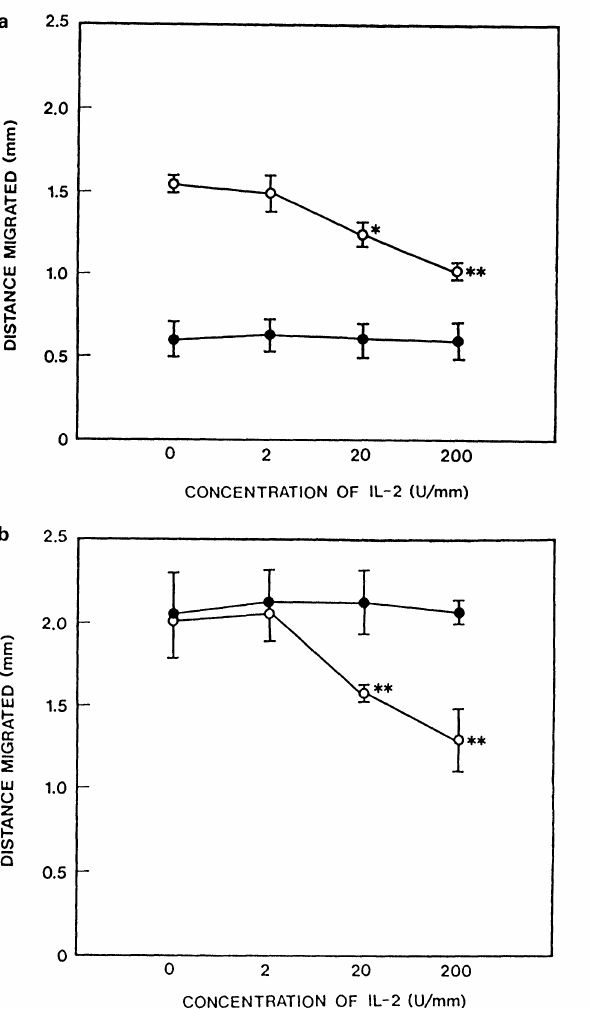
FIG. 2. (a) random and (b) stimulated migration under agarose of neutrophils (0) and monocytes ((C)) treated with IL-2. (Data for (a) and (b) were collected from the same experiments.) Monocyte random and stimulated migration decreased with increasing L-2 concentrations while neutrophil migration remained